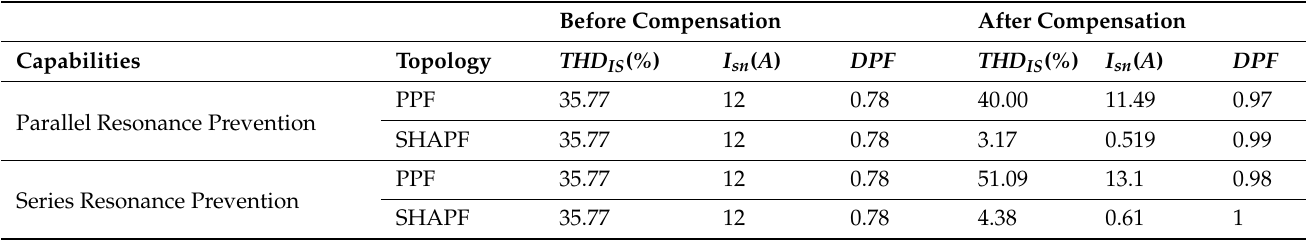
Table 7. Comparative analysis before and after applying SHAPF and PPF.